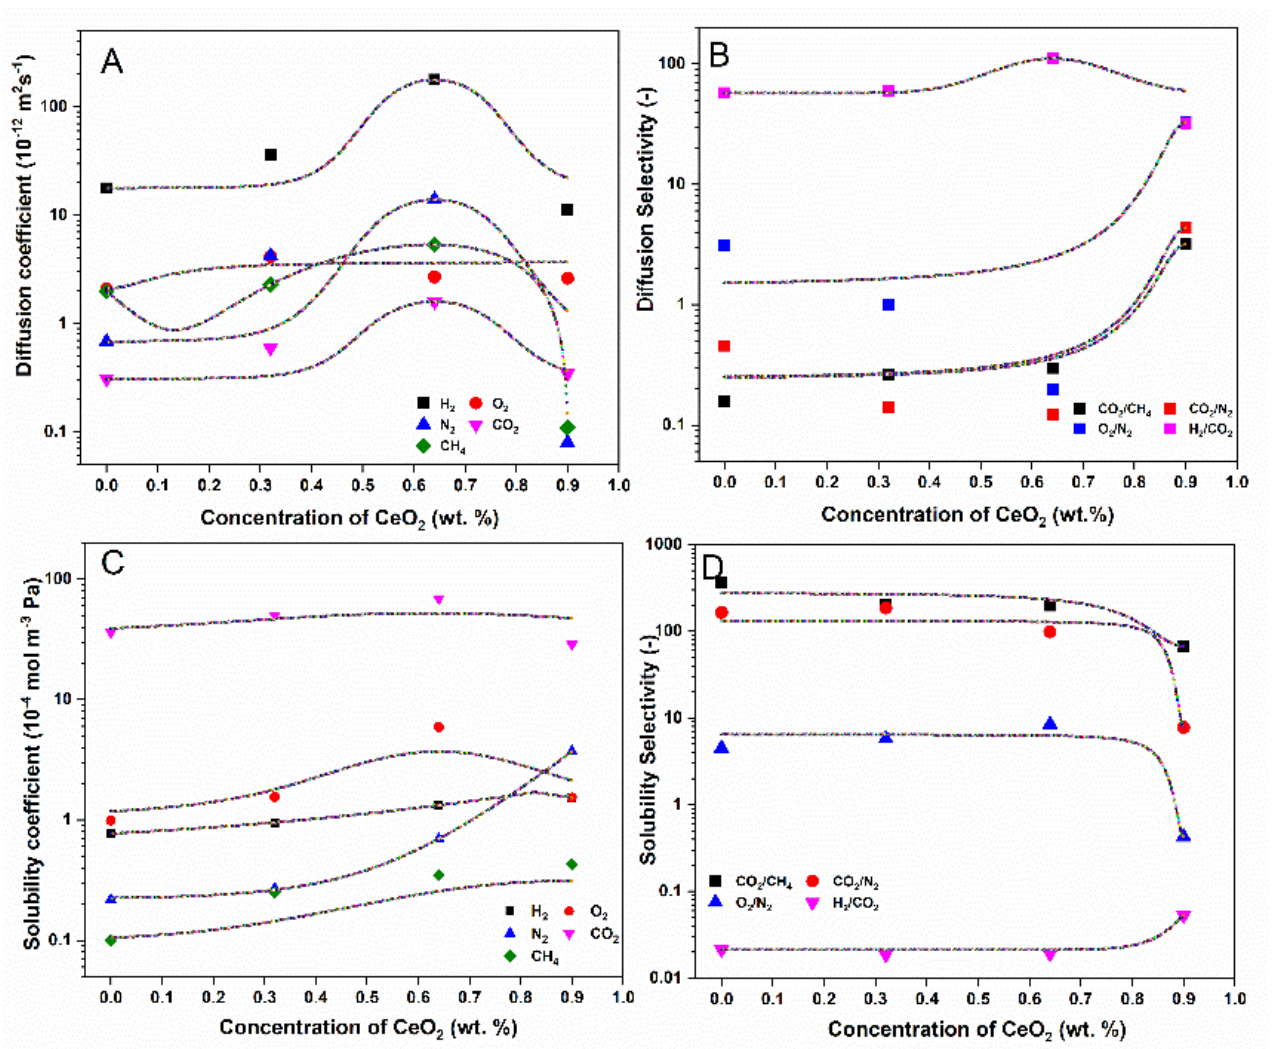
Figure 12. ( A ) Diffusion coefficient, ( B ) diffusion selectivity, ( C ) solubility coefficient and ( D ) solubility selectivity between selected gas pairs as a function of CeO 2 filler concentration. Lines are plotted for visualization.